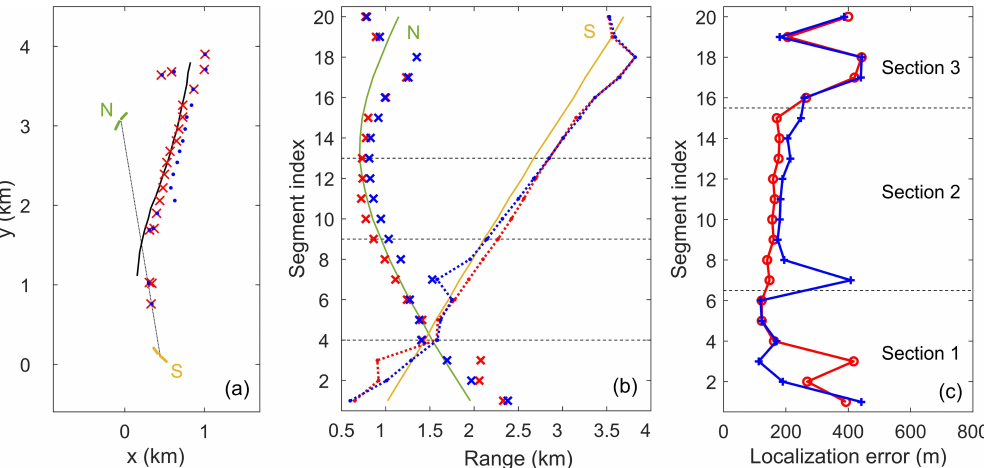
Figure 2. (Color online) Localization results of GMA and N-MUSIC with 198 Hz for the 20 segments processed. ( a ) Position estimates of GMA (red cross symbols) and N-MUSIC (filled blue circles). Solid black line indicates true source track. ( b ) Range estimates of GMA to HLA North (red cross symbols) and HLA South (dotted red line with filled circles), and range estimates of N-MUSIC to HLA North (blue cross symbols) and HLA South (dotted blue line with filled circles). Solid green line and yellow line indicate true range to HLA North and HLA South, respectively. ( c ) Localization errors of GMA (solid red line with red circles) and N-MUSIC (solid blue line with plus